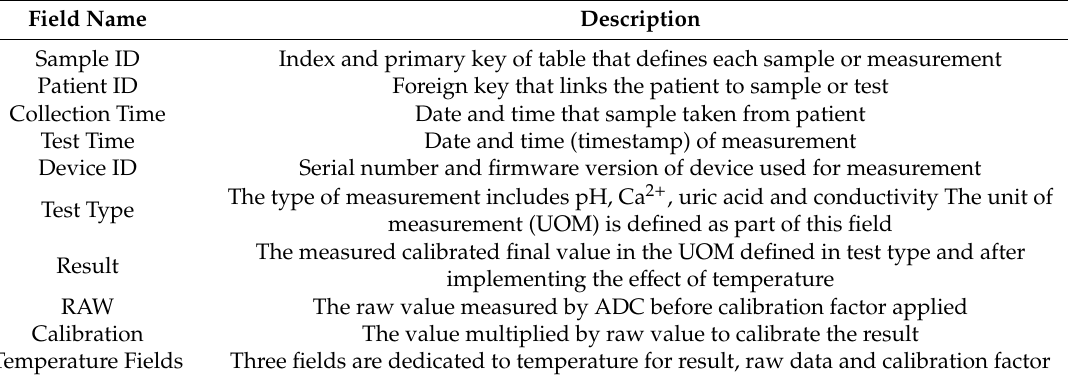
Table 1. Database samples table fields’ descriptions.